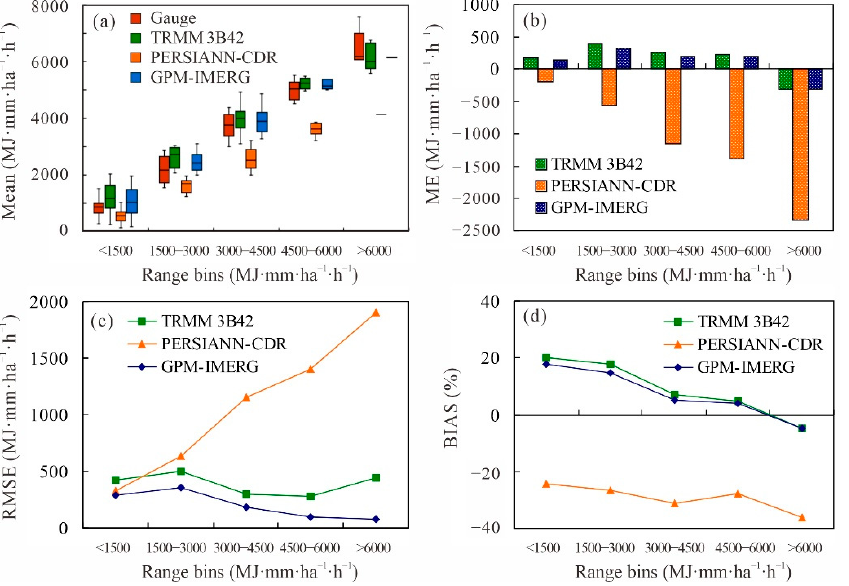
Figure 6. Distribution of the Mean ( a ), ME ( b ), RMSE ( c ), and BIAS ( d ) of rainfall erosivity in different intensity categories on seasonal scale.